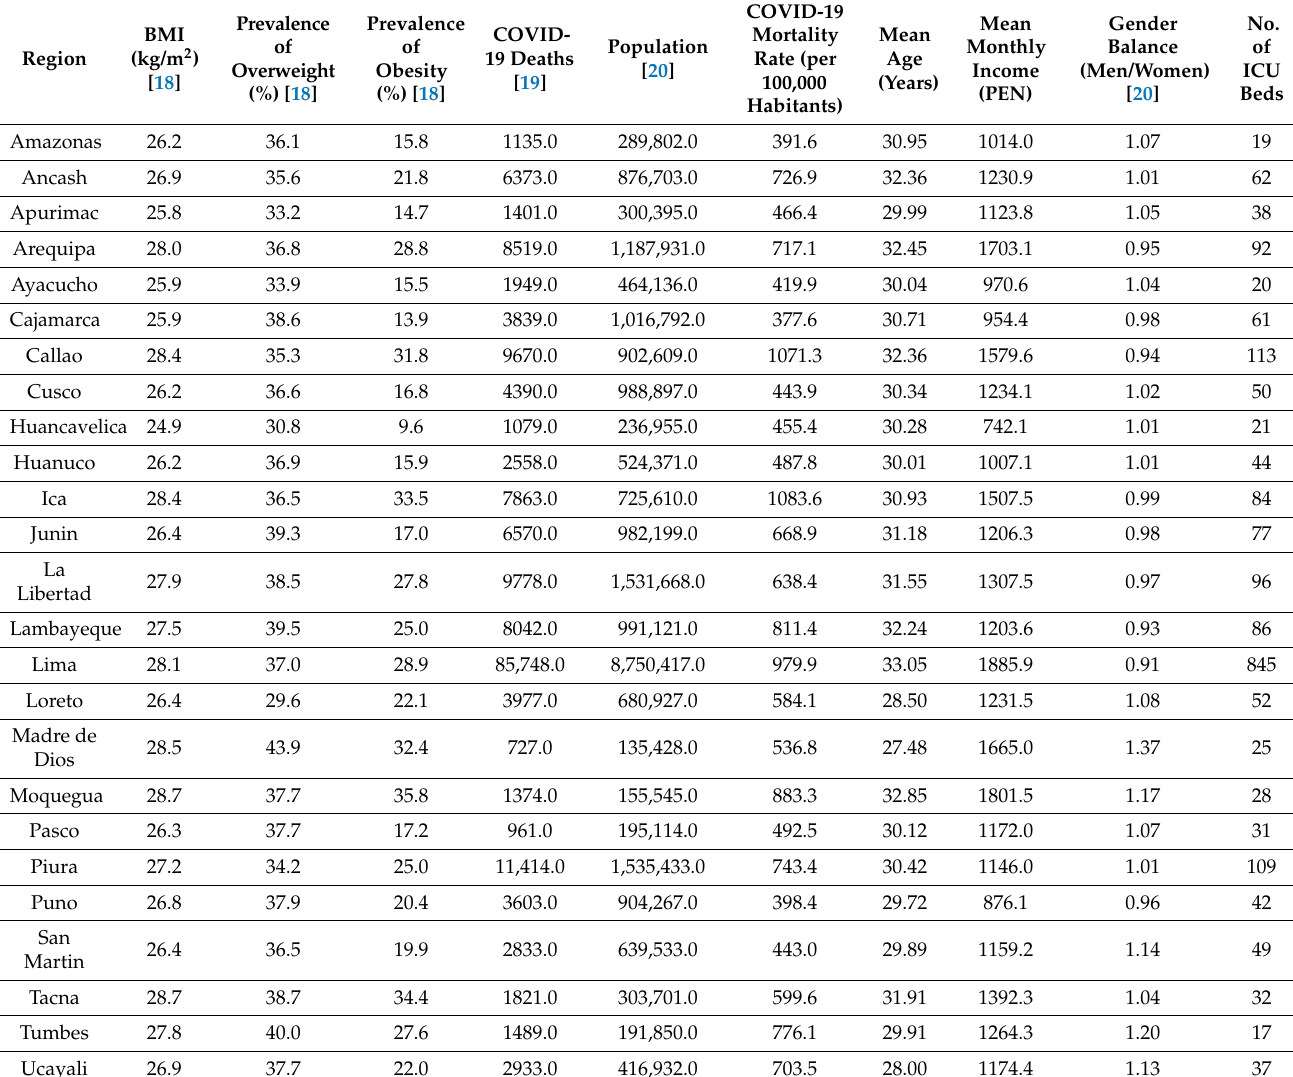
Table 1. BMI average, prevalence of overweight and obesity, and COVID-19 mortality rate in ≥ 15-year-olds in 25 Peruvian regions, March 2020 to June 2021.